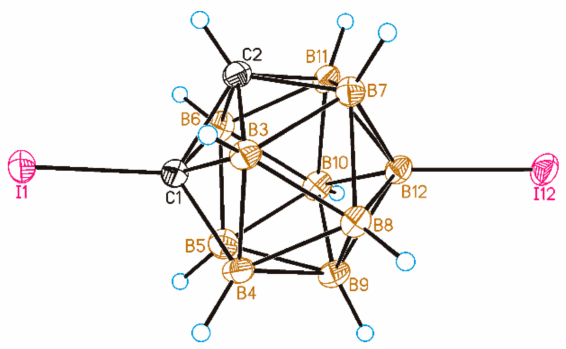
Figure 1. General view of 1,12-I 2 -1,2-C 2 B 10 H 10 . Thermal ellipsoids are given at 50% probability